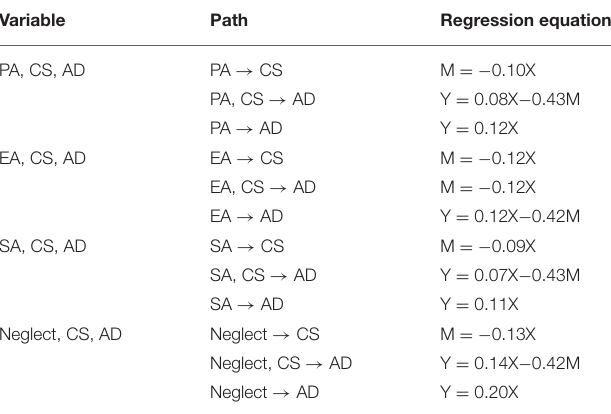
TABLE 5 | Regression equations of the mediating effect of coping style. Variable